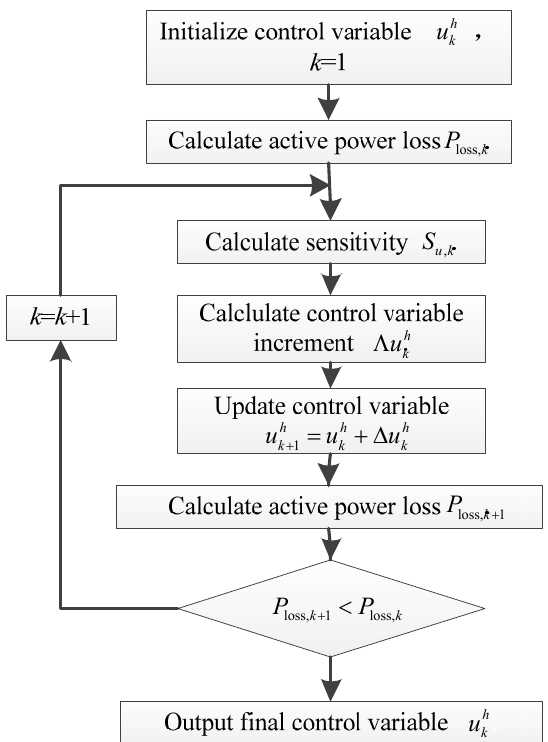
Figure 5. Flow chart of control variable fine adjustment method.